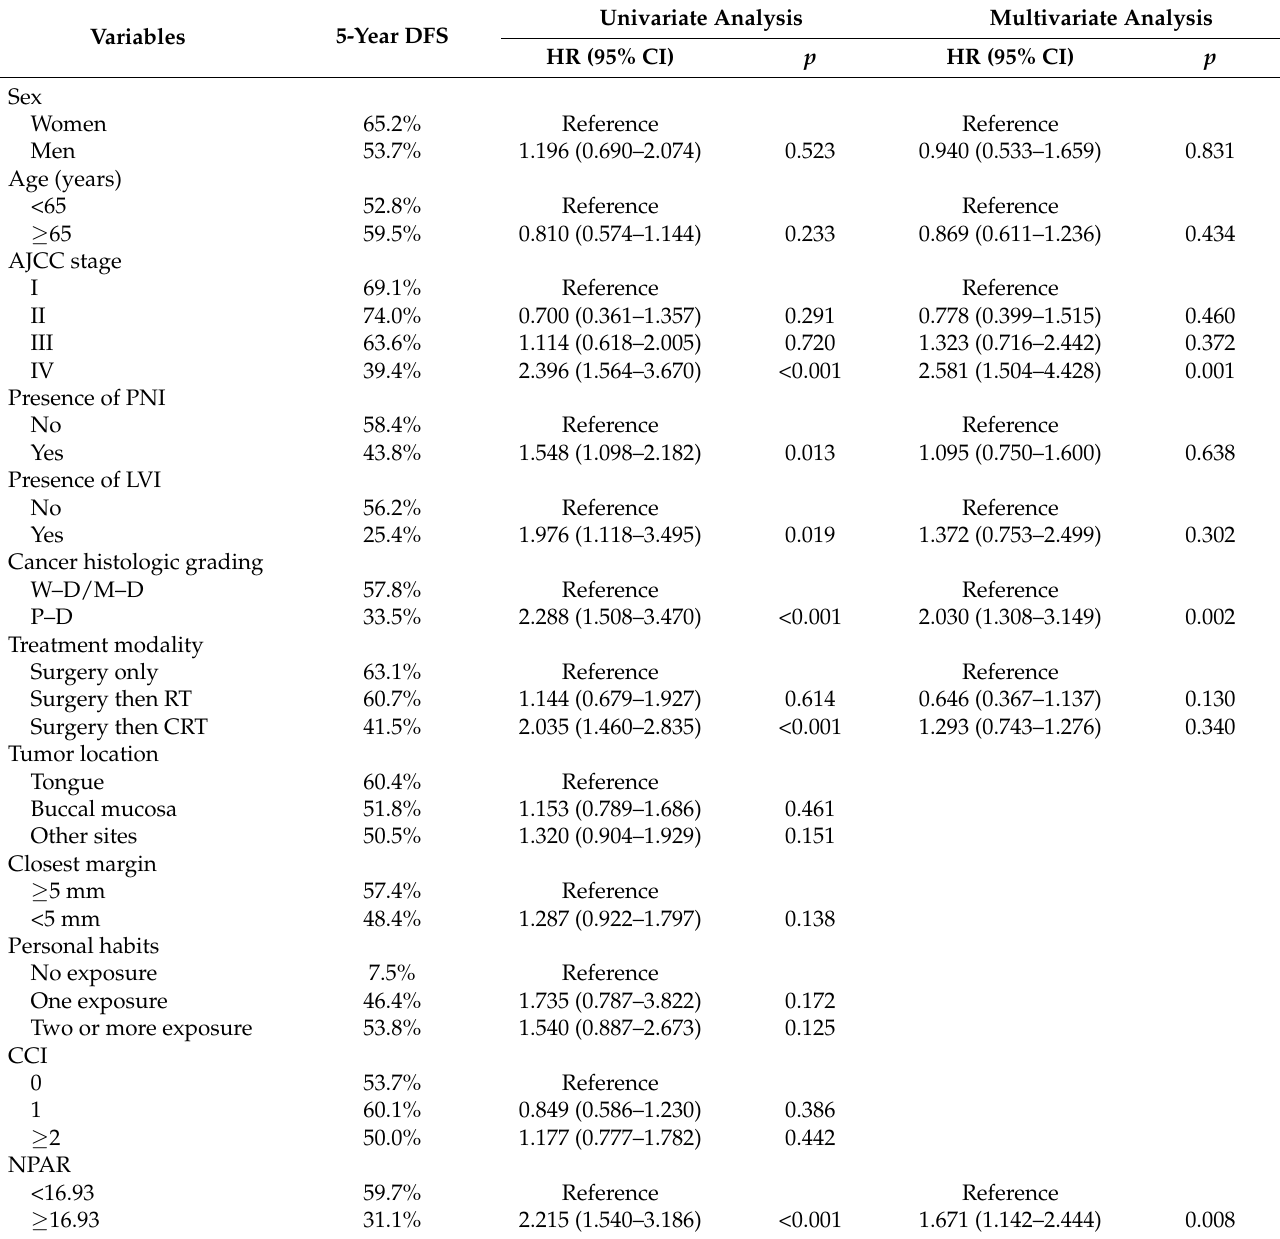
Table 3. Univariate and multivariate analysis of DFS of 368 patients with oral cavity squamous cell